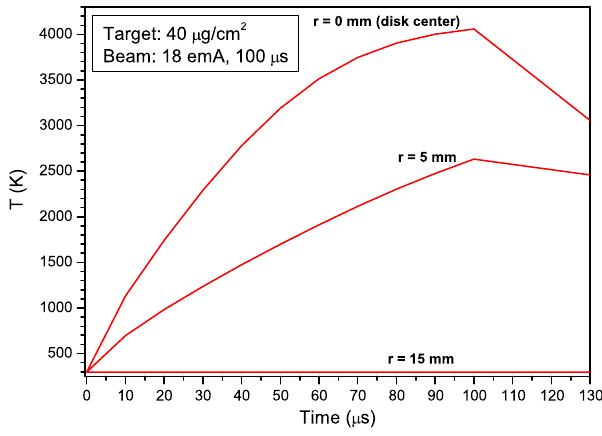
FIG. 13. Same as in Fig. 11, but for foil thickness ¼ 40 μ g = cm 2 using a uniform charge distribution of 40 þ